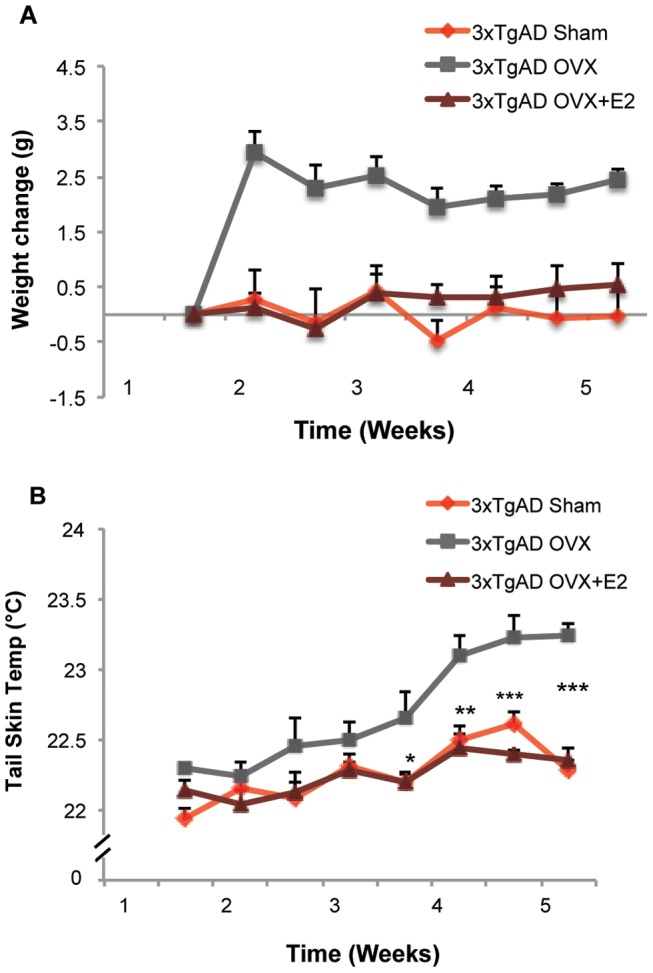
Ovariectomy (OVX) induced increase in body weight and tail skin temperature and prevention by 17β-estradiol.A. OVX induced a significant increase in body weight (0.27±0.54 vs. 2.94±0.39, F (2, 13) = 12.61, p<0.001, n = 5–6) one week after surgery, which was sustained through the duration of the experiment. E2 treatment (50 µg/kg, SC) initiated at time of OVX prevented the OVX-induced body weight gain. B. OVX induced a significant rise (22.28±0.07 vs. 23.24±0.08, F (2,13) = 42.21, p<0.001, n = 5–6) in tail skin temperature 4 weeks after surgery, and E2 treatment (50 µg/kg, SC) initiated at time of OVX prevented the OVX-induced increase in tail skin temperature.